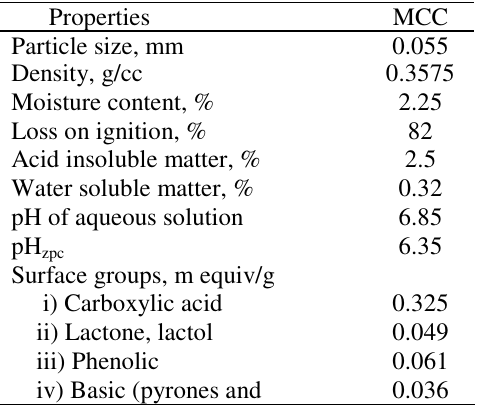
Table 1. Characteristics of the adsorbent